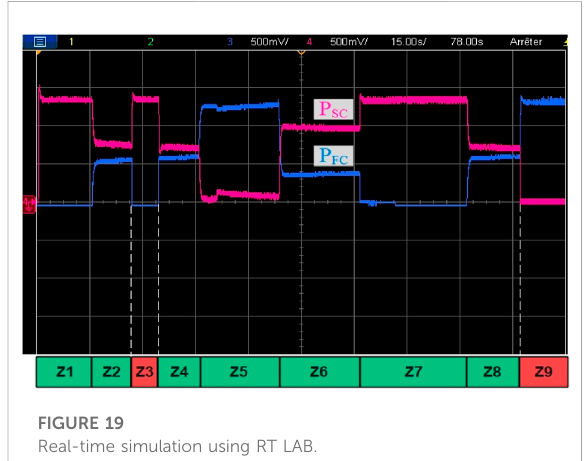
FIGURE 19 Real-time simulation using RT LAB. FIGURE 20